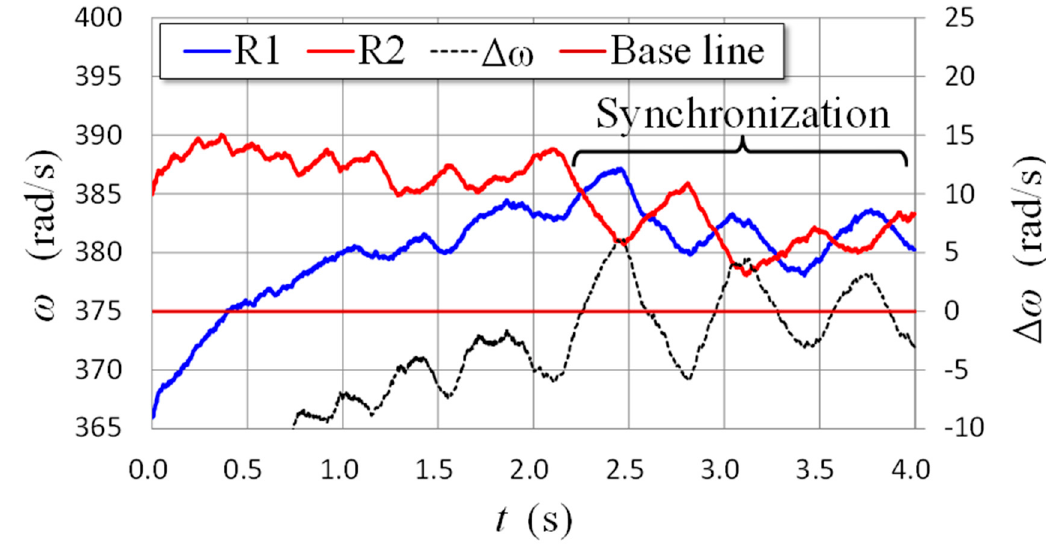
Figure 17. State of phase synchronization in angular velocities of two rotors in CD layout with gap / D = 0.2.